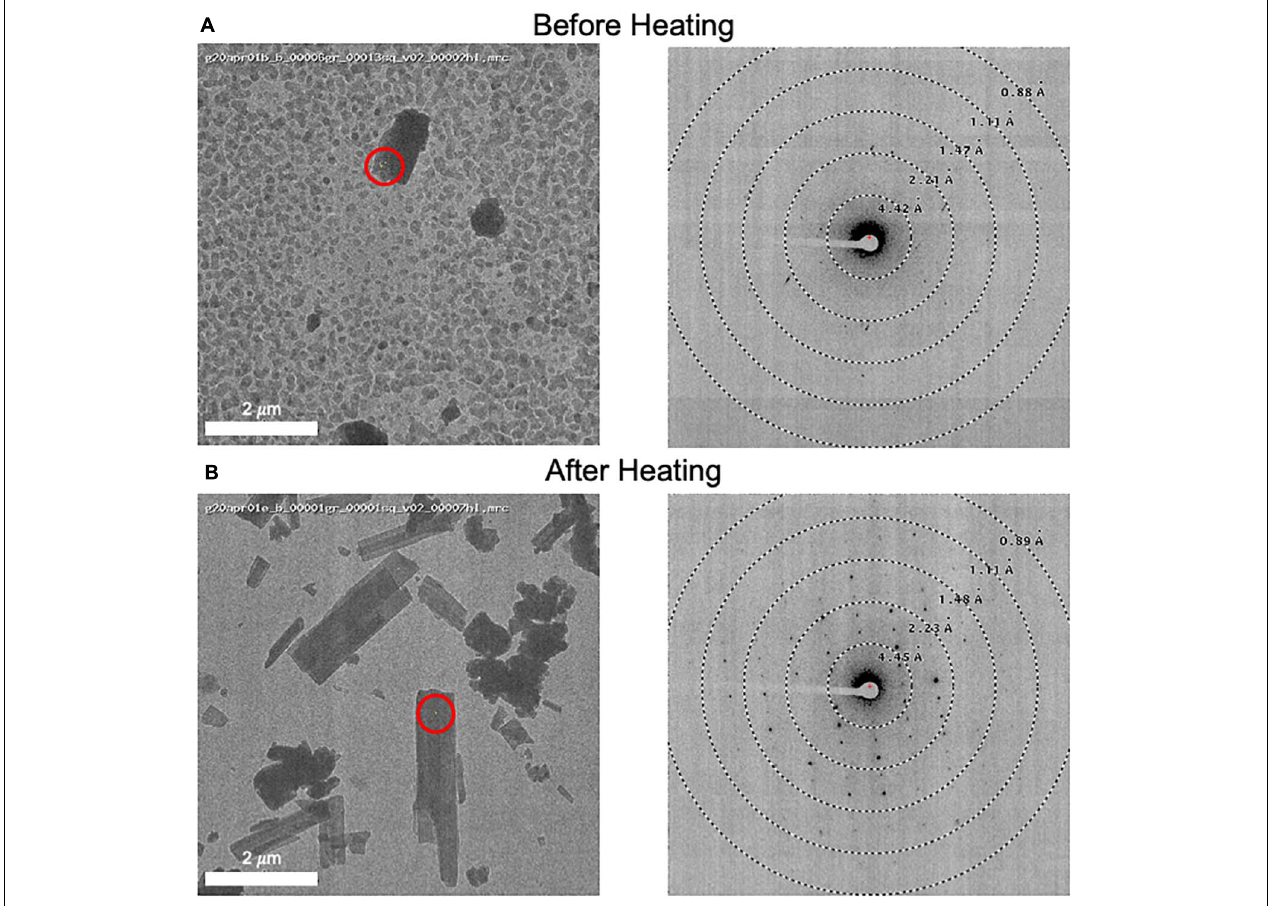
FIGURE 3 | (A) An image of a client sample (left) and its diffraction pattern (right). The area targeted is indicated by a red circle showing the approximate beam diameter. Note the grainy background material and poor diffraction. (B) This grid was removed from the microscope and subsequently heated to 50 ◦ C for 10 minutes prior to re-freezing in liquid nitrogen. An image (left) and its diffraction pattern (right) are shown. Note the disappearance of the grainy background material and the improved diffraction pattern. We also note that the MicroED structure determined from these crystals matches the experimentally collected XRPD pattern and therefore we do not believe that heating caused a form change in this